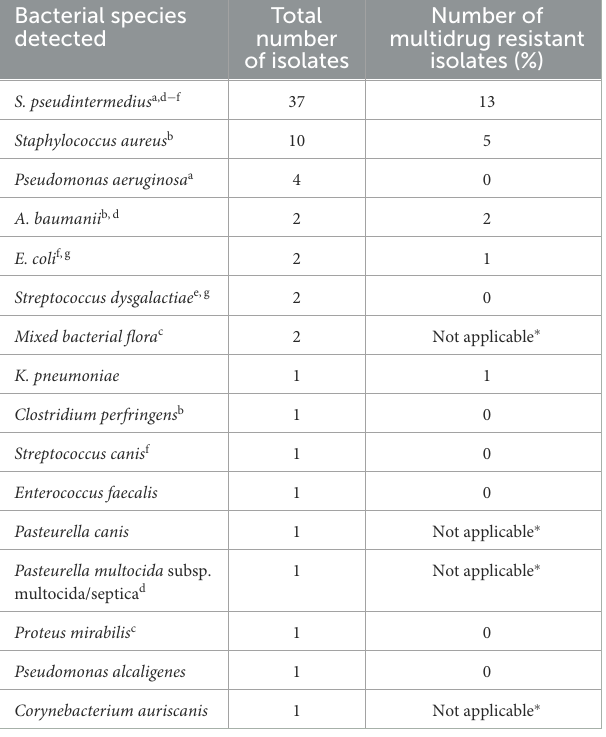
Theboldvaluesrespresentthetotalnumberofcasesintherespectivecategory. TABLE 5 Bacterial species and number of multidrug resistant bacteria isolated from 91 bacteriological culture collected from 80 dogs treated with